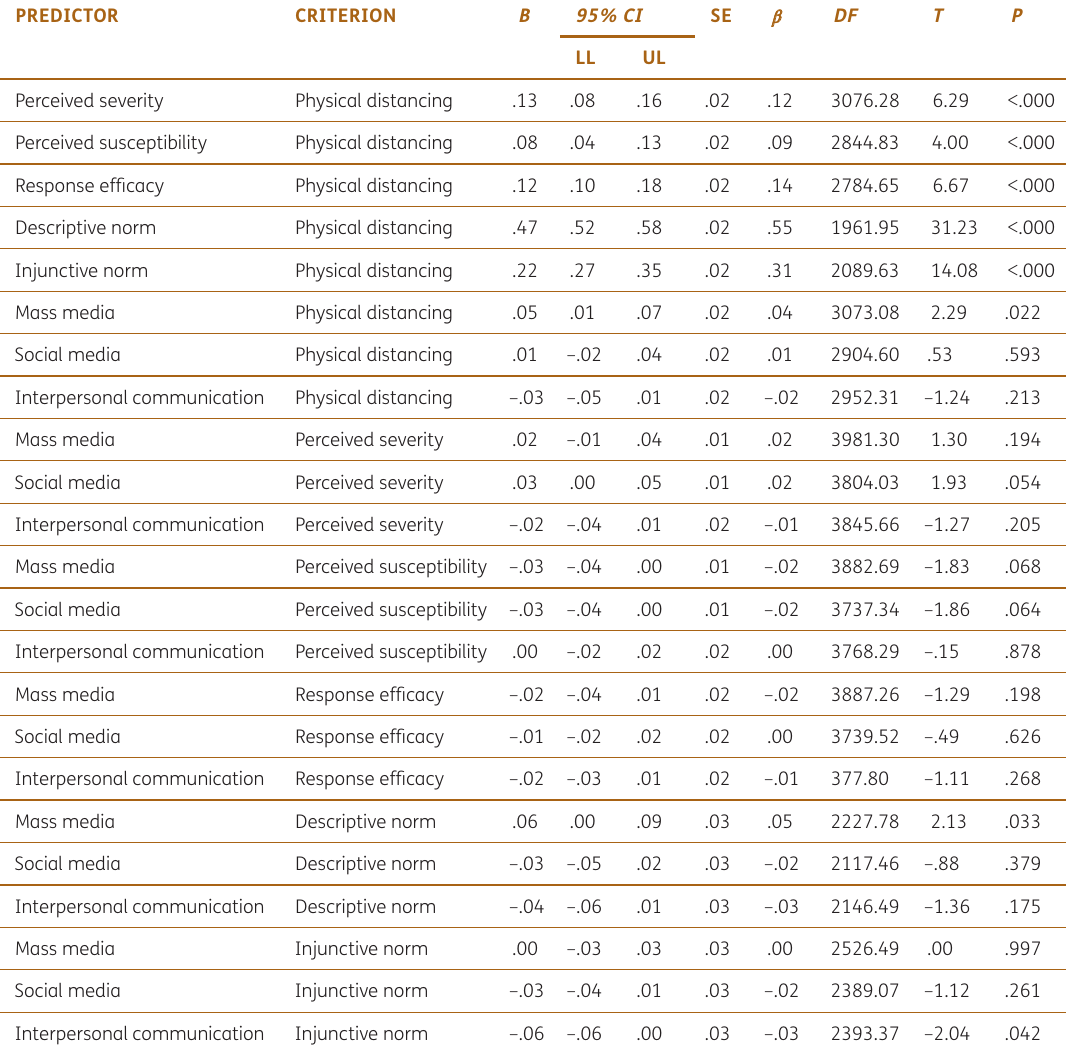
Table 4 Univariate Linear Mixed-Effects Predicting Physical Distancing Behavior in the School